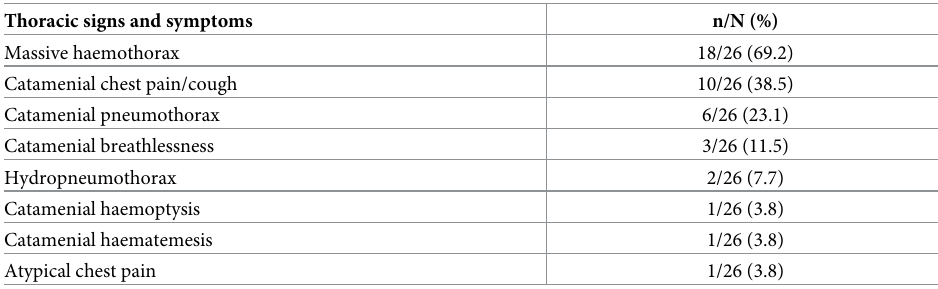
Table 2. Summary of the clinical signs and symptoms in the test